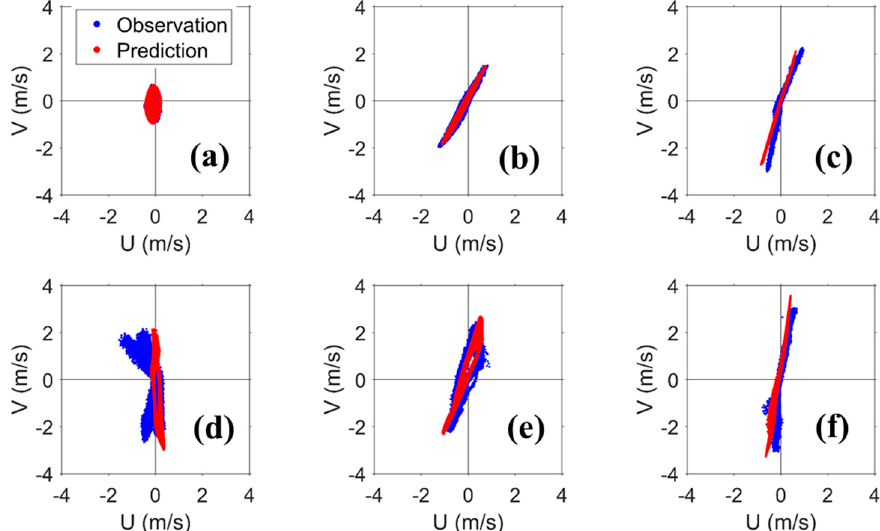
Figure 4. Scatterplots of U and V velocity components for model-predicted depth-averaged tidal currents and NOAA observations at six ADCP locations inside Cook Inlet ( a ) COI0514; ( b ) COI0511; ( c ) COI0508; ( d ) COI0501; ( e ) COI0502; ( f ) COI0503. The plots were generated from depth-averaged velocity time series for both model predictions and field observations.